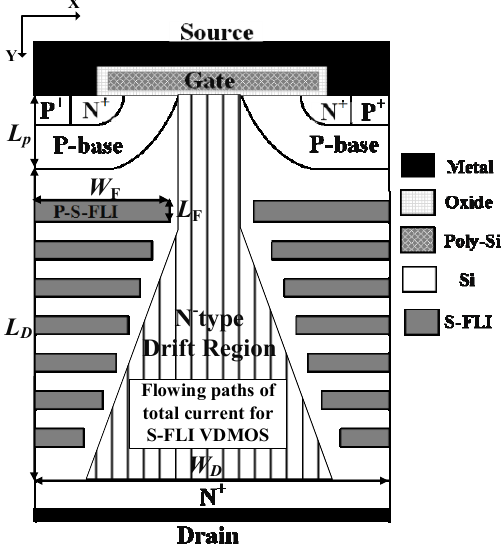
Figure 1. Cross section of S-FLI VDMOS with the number of rings of 7. Two Step Floating Islands at the same Y coordinate constitute a ring. ( L D is the length of N-drift region. L P is the depth of the P-base. W D is the width of device. L F is the depth of Floating Islands. W F is the length of Floating Islands. N D is the concentration of N-drift region. N SUB is the concentration of P-substrate. N P is the concentration of P-base region. Rings is the number of rings, in which two Step Floating Islands at the same Y coordinate constitute a ring.).